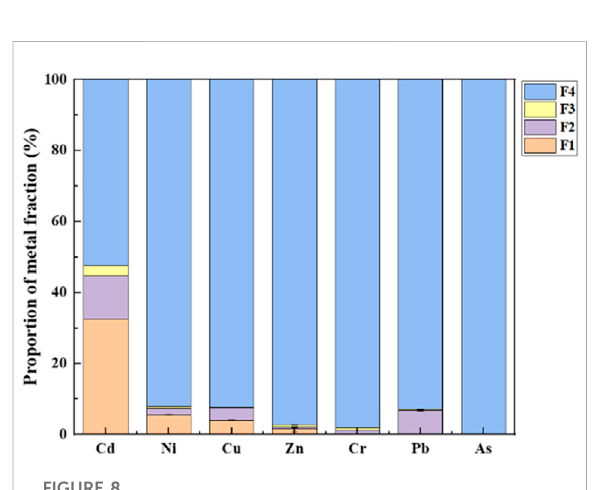
FIGURE 8 The BCR sequential extraction results of trace toxic metals.